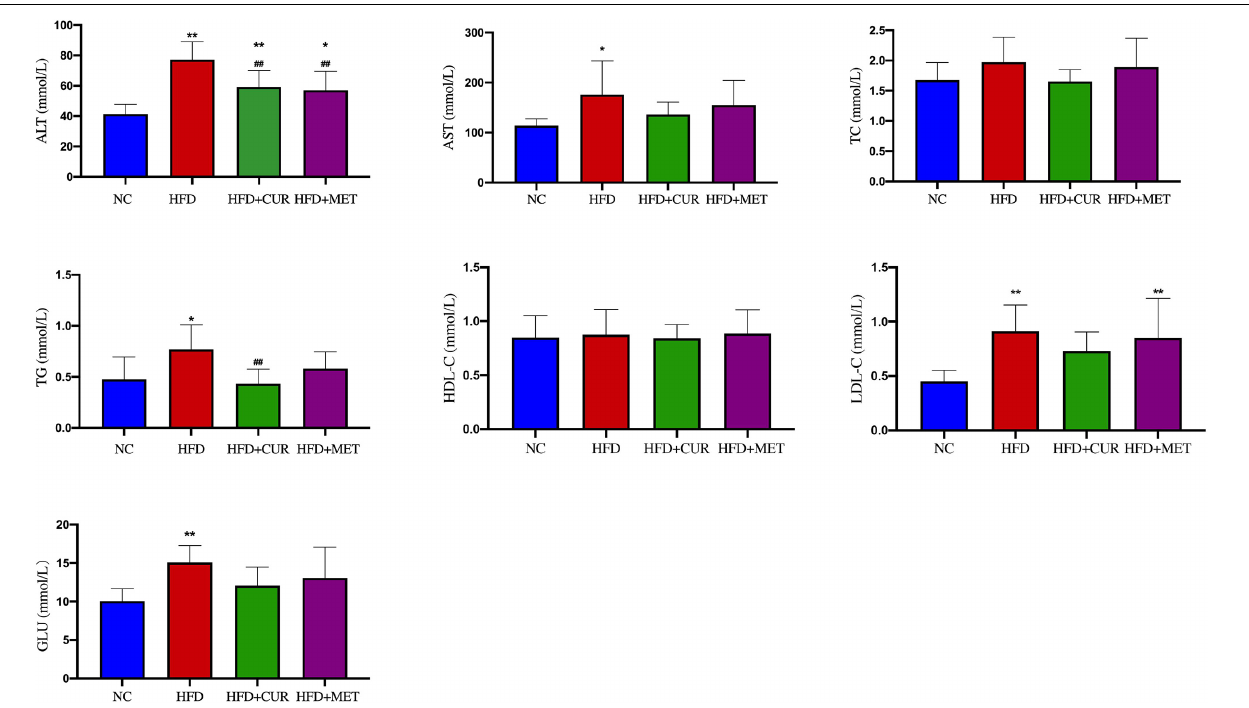
FIGURE 2 | Influence of CUR and MET on the serum biochemical index. Seven rats per group ( n = 7). Values were presented as the means ± SD for each group. * p < 0.05, ** p < 0.01 compared with the NC group. ## p < 0.01 compared with the HFD group.